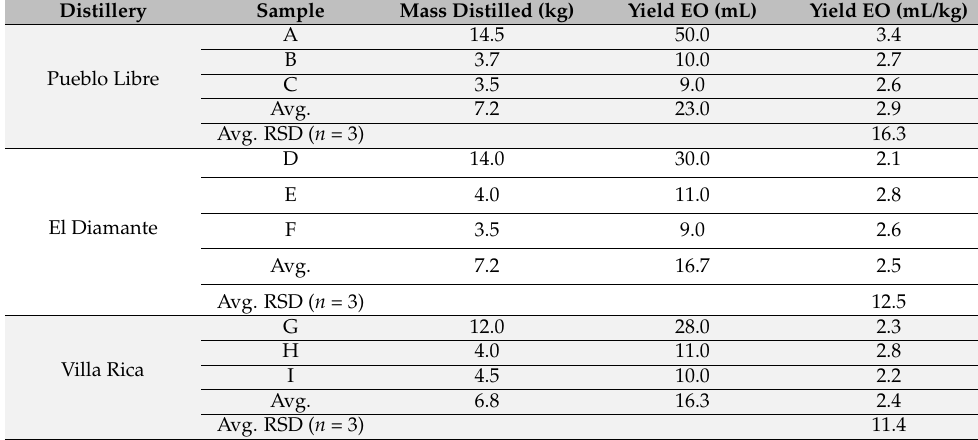
Table 3. Yield data, including mass of plant material distilled (kg), essential oil yield (mL), and calculated yield (mL/kg). Average calculated yields per distillery range from 2.4–2.9 mL/kg. The relative standard deviation (RSD) is provided for essential oil yield in each